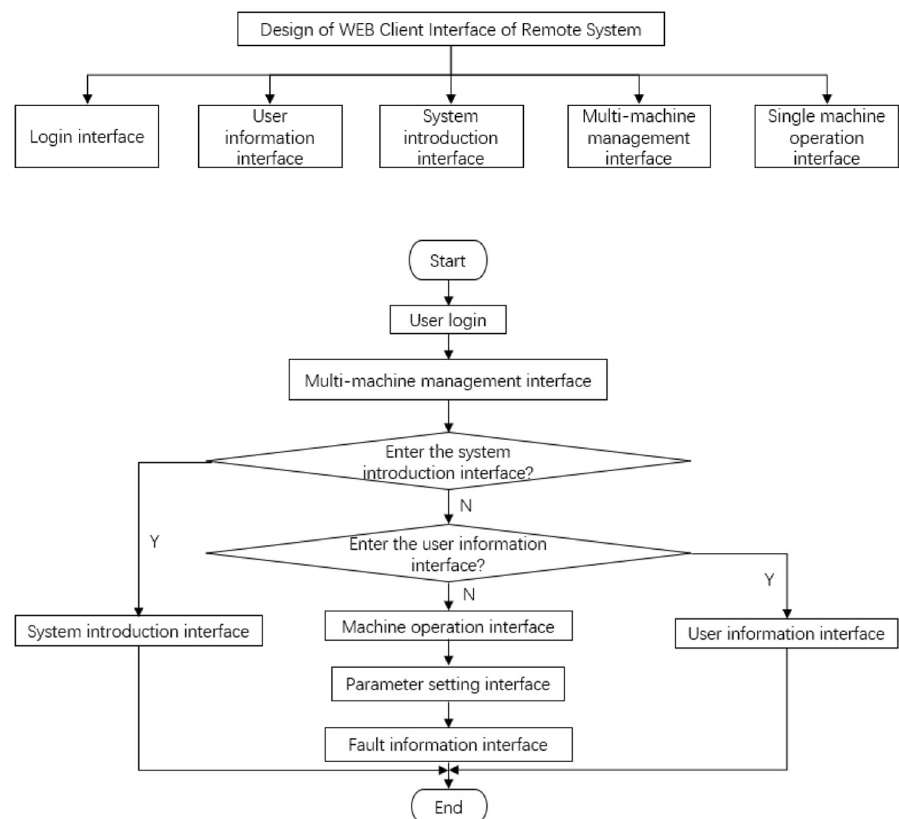
Fig. 13 The block diagram of the overall structure of the cli- ent web interface